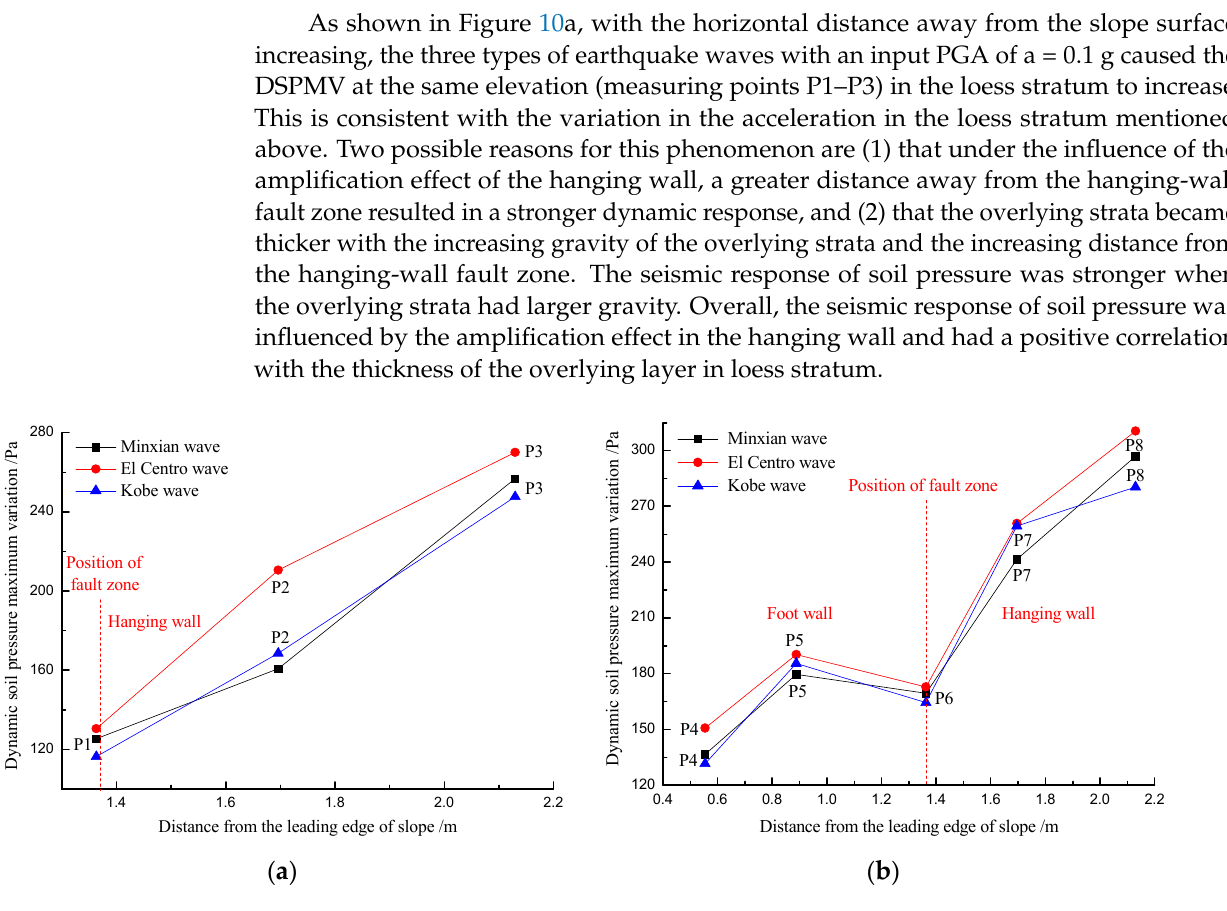
Figure 10. Dynamic soil pressure maximum variation (DSPMV) ( a ) in loess stratum and ( b ) at L–W interface in response to three types of earthquake waves with input PGA of a = 0.1 g.